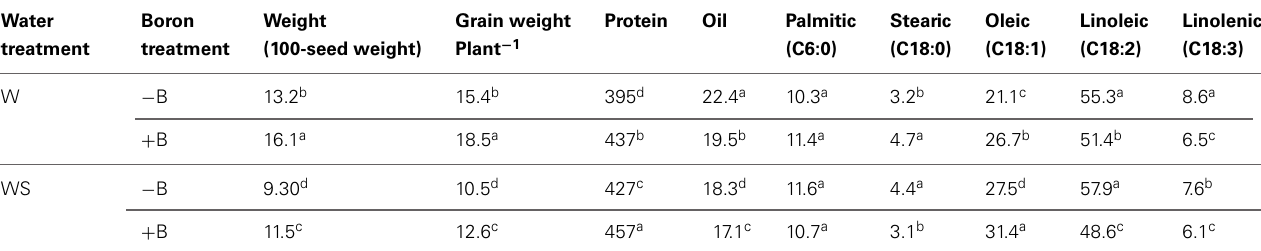
Table 2 | Effects of foliar boron (1.1kg B ha − 1 ) and water stress on seed weights (g), seed protein, oil, and fatty acid concentrations (g constituent kg − 1 dwt).